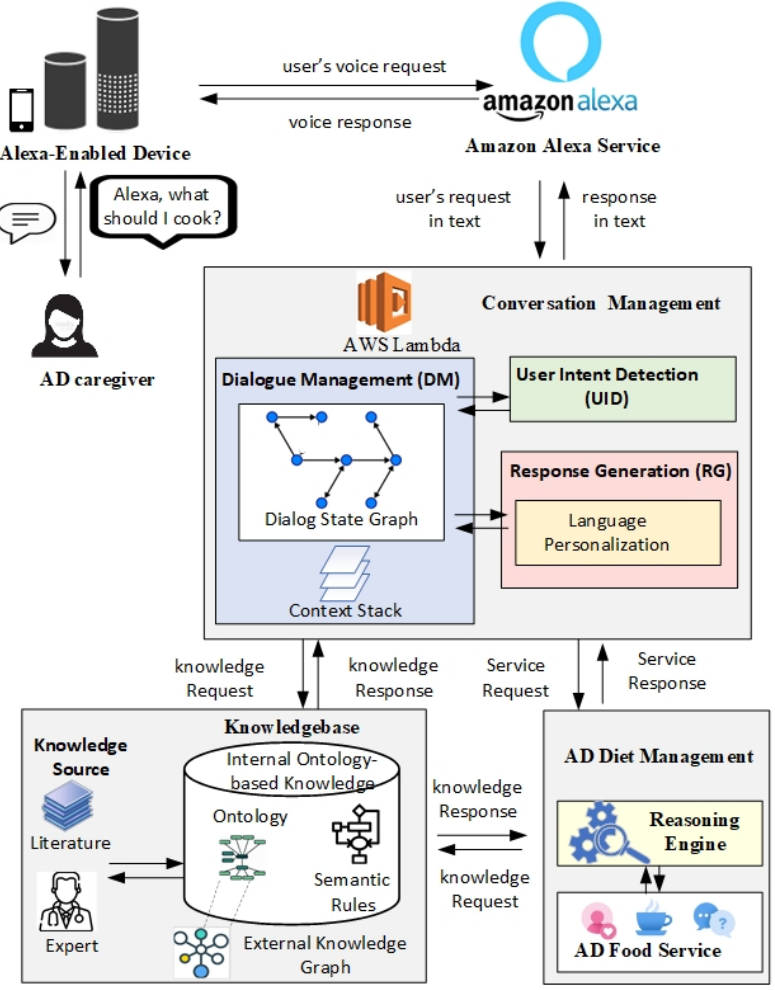
Figure 1. Architecture of the system. AD: Alzheimer disease; AWS: Amazon Web